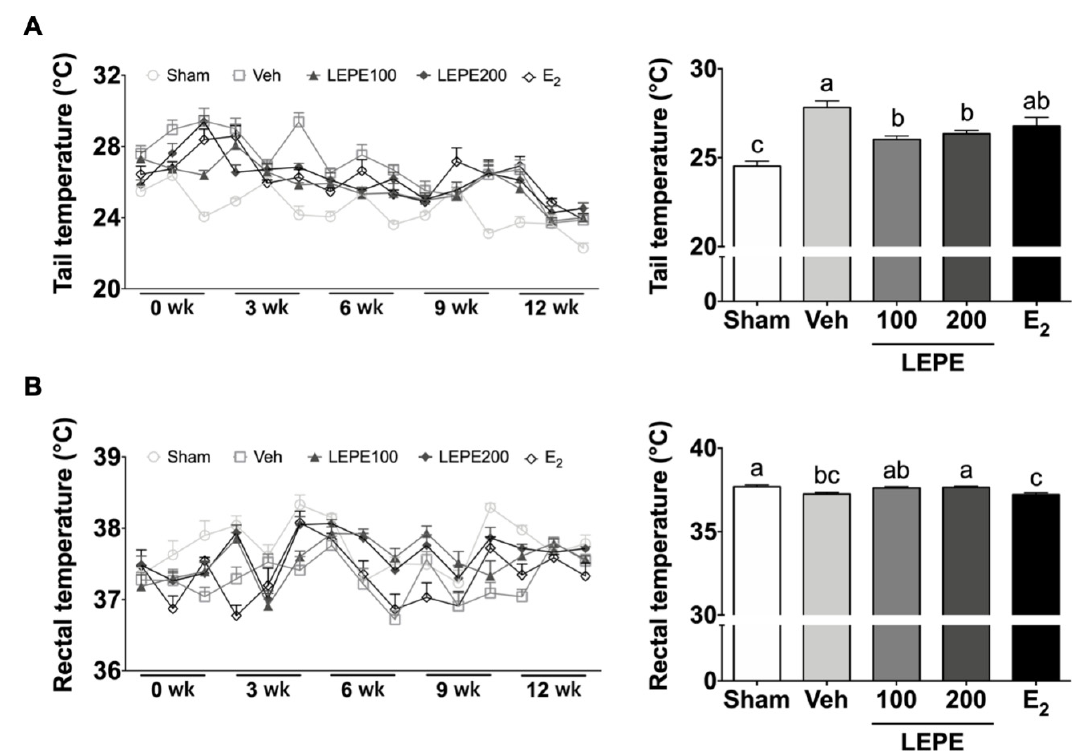
Figure 3. The effects of LEPE on hot flash-like responses via tail skin and rectal temperature measurements of the ovariectomized rat model. ( A ) Tail temperature and ( B ) rectal temperature. Sham, control sham-operated rats; Veh, ovariectomized (OVX) rats treated with vehicle; LEPE100, OVX rats treated with Leonurus japonicus Houtt, Eclipta prostrata L., and Pueraria lobata Ohwi extract (LEPE) 100 mg/kg bw; LEPE200, OVX rats treated with LEPE 200 mg/kg bw; E 2 , positive control, OVX rats injected with estradiol 3.0 μ g/kg bw. Data are shown as mean ± SEM ( n = 12). a–c Significant differences were analyzed by one-way ANOVA with Tukey’s multiple comparisons between groups ( p < 0.05).